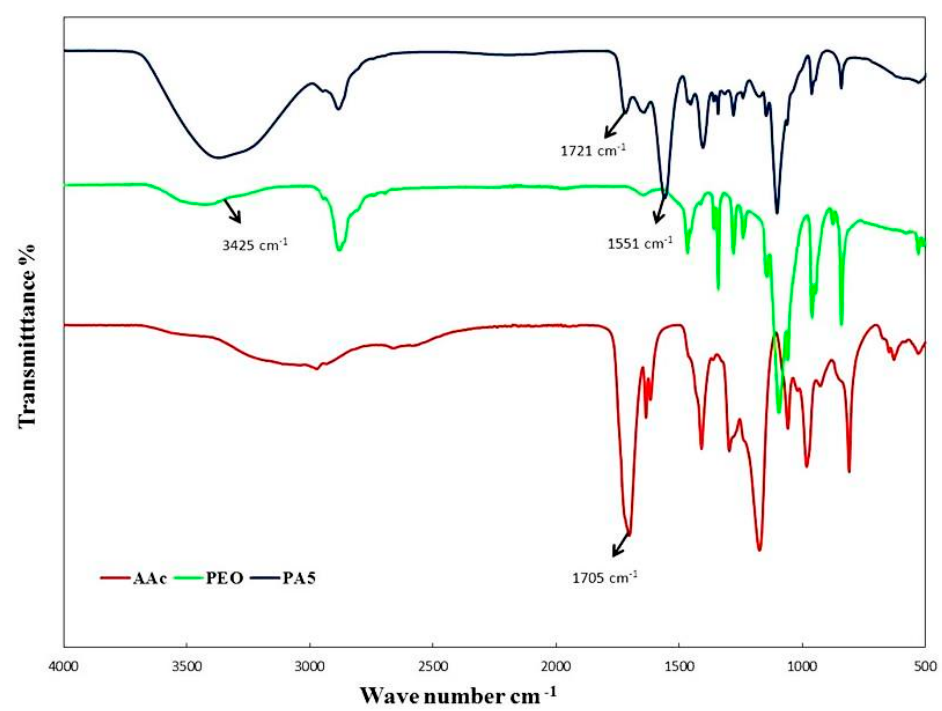
Figure 4. FT-IR spectra of pure AAc, pure PEO, and PA5 hydrogel blend prepared at 30 kGy radiation dose with ranges 4000–500 cm − 1 .